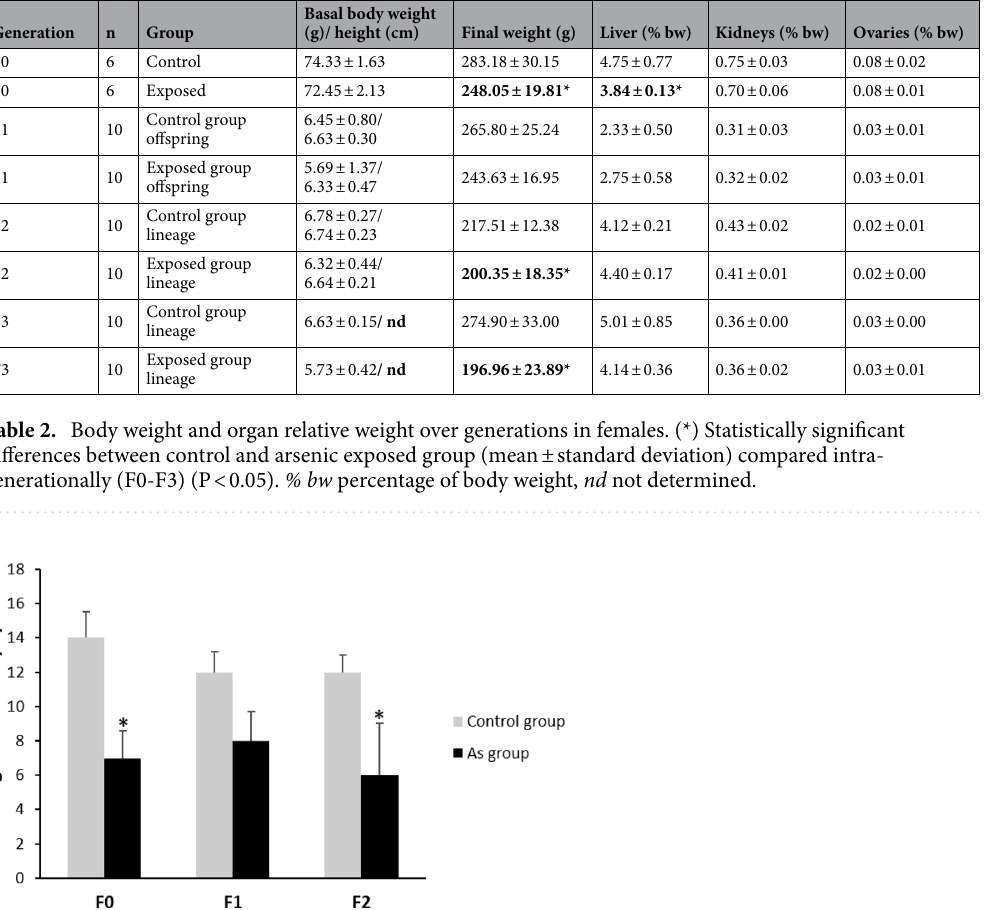
Figure 1. Average number of pups from F0, F1 and F2 generation. (*) statistically significant differences between control (n = 15) and arsenic exposed group (n = 15) compared intra-generationally (P < 0.05). Error bars: standard